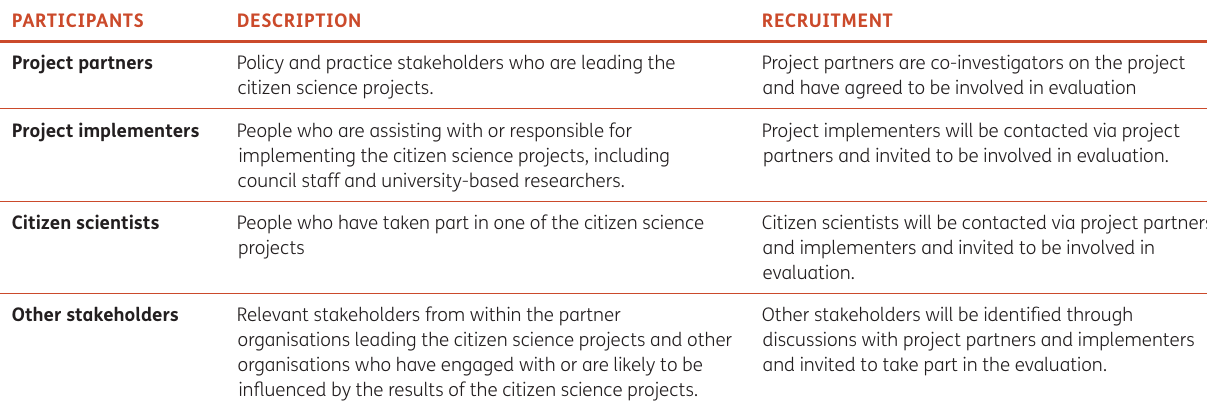
Table 1 Overview of participants and